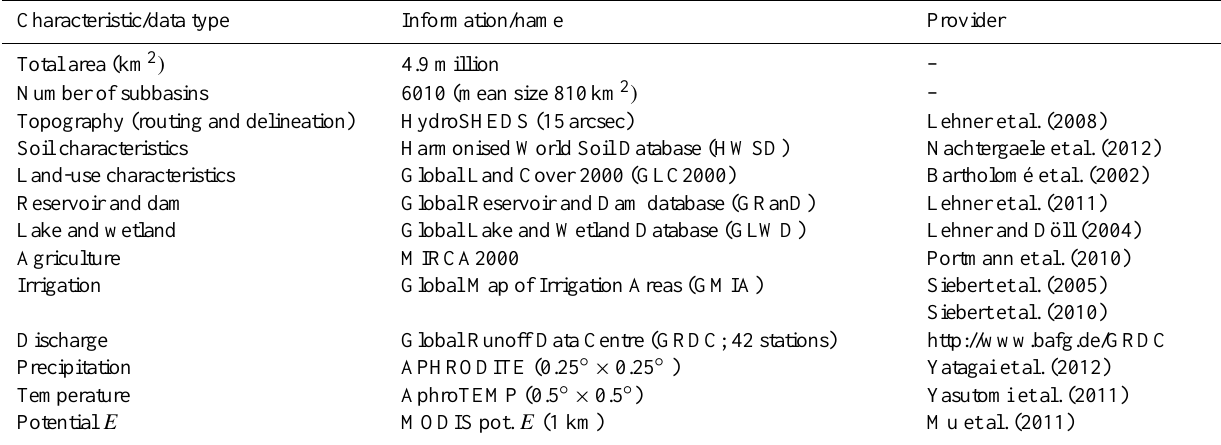
Figure 2. (Left) Map of the Indian subcontinent (model domain). Results will be shown from investigation areas with a star in the order of their numbering. (Right) Annual cycles (1971–1979) at four river systems (a–d) of various climate ( P – observed precipitation, Act. E – modelled actual evapotranspiration, Q – observed discharge). Table 1. Data sources and characteristics of the India-HYPE v.1.0 model